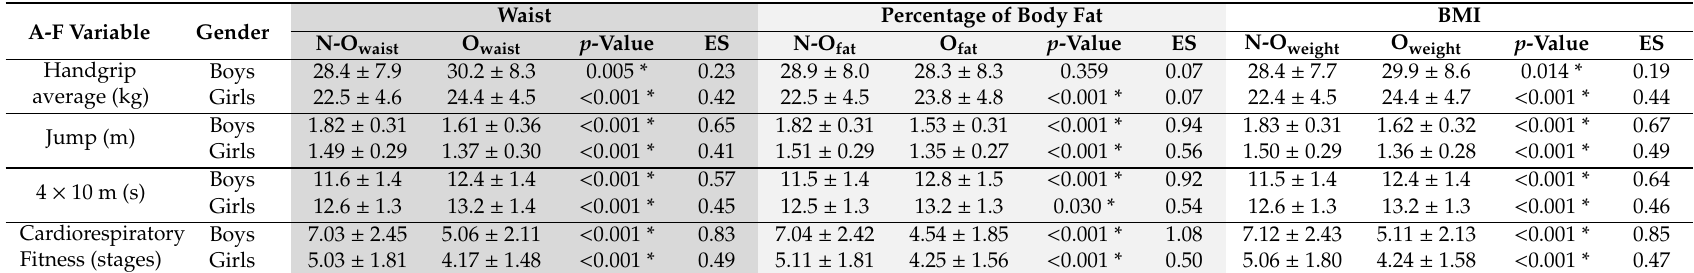
Table 5. Physical fitness values in over and non-over boys and girls according to selected body composition parameters.